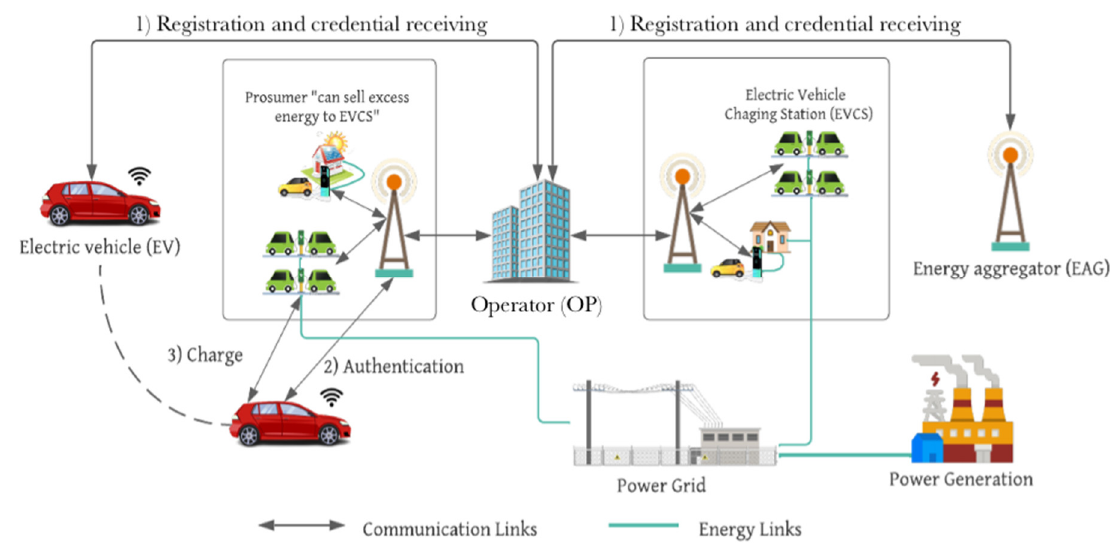
Figure 3. Proposed system architecture.